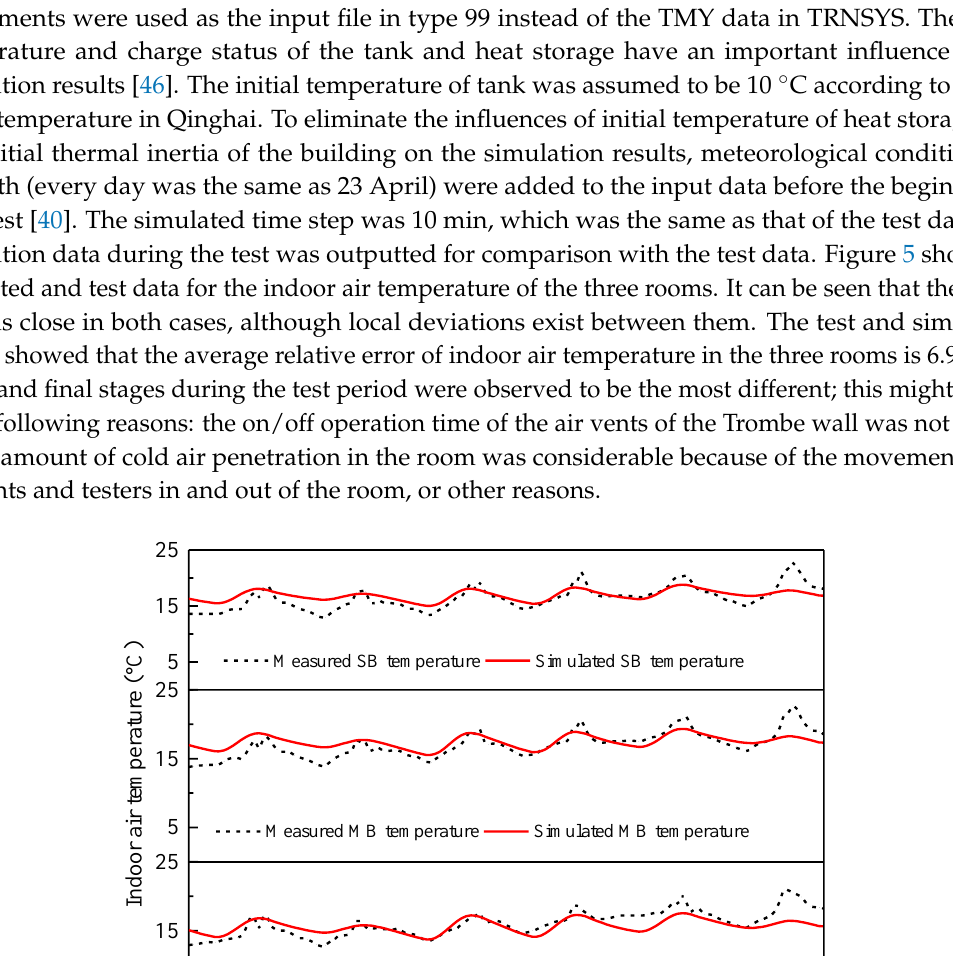
Table 5. Comparison of the simulation results and field test data of the system thermal performance.